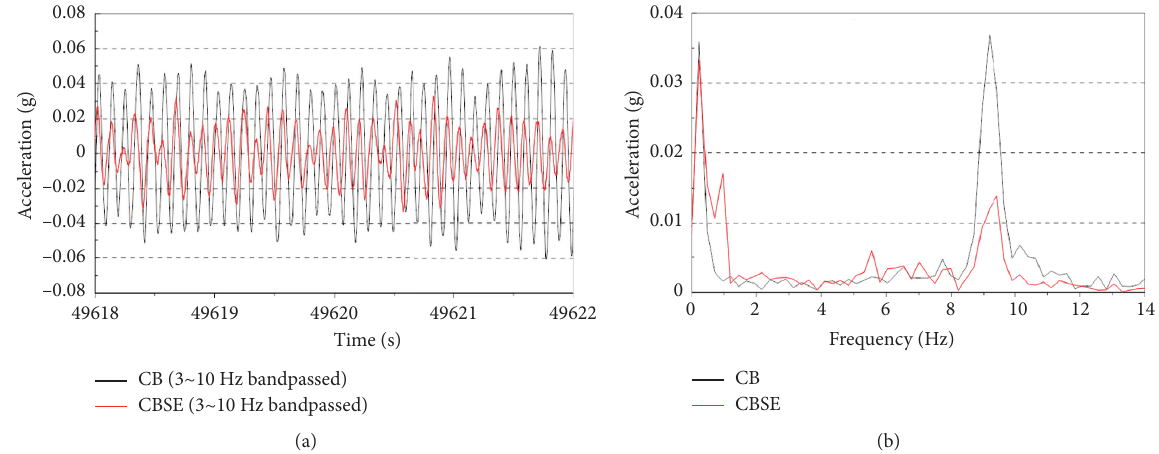
Figure 18: Comparisons of the lateral vibration on the CBSE and CB: (a) time history of acceleration and the corresponding; (b) spectrums when the wheel experiences little wear.